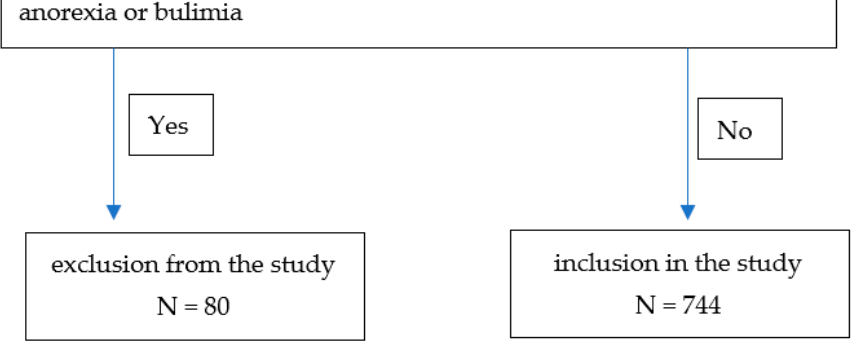
Overweight N = 221